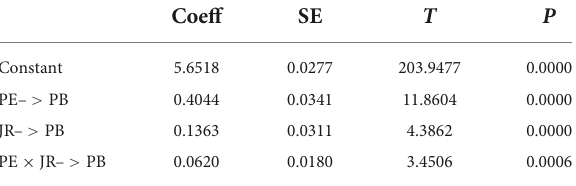
TABLE 10 Results of the moderating effect.